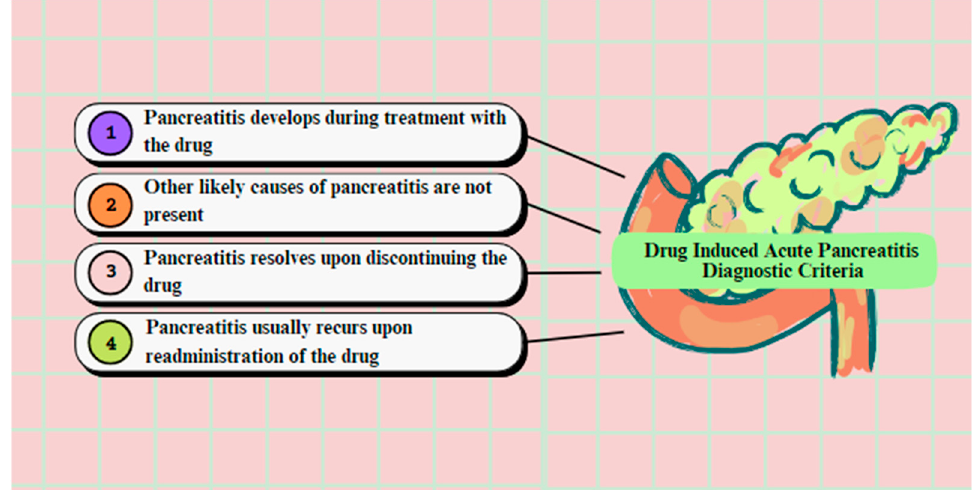
Figure 3. Diagnostic criteria of drug-induced acute pancreatitis.